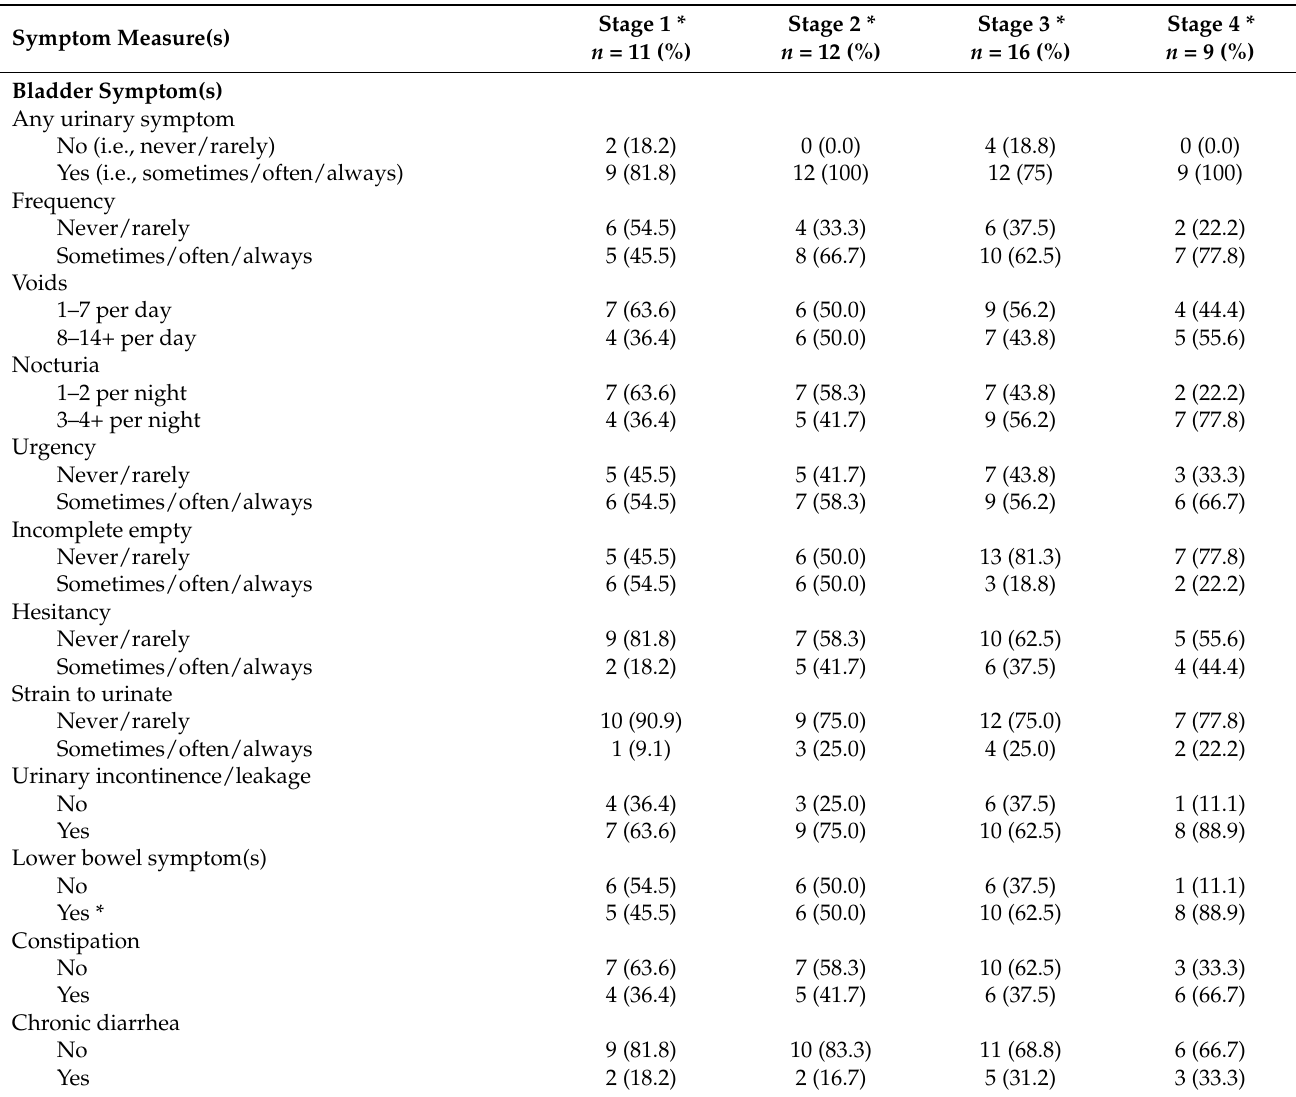
Table 4. Bladder, lower bowel, and sexual symptoms stratified by disease